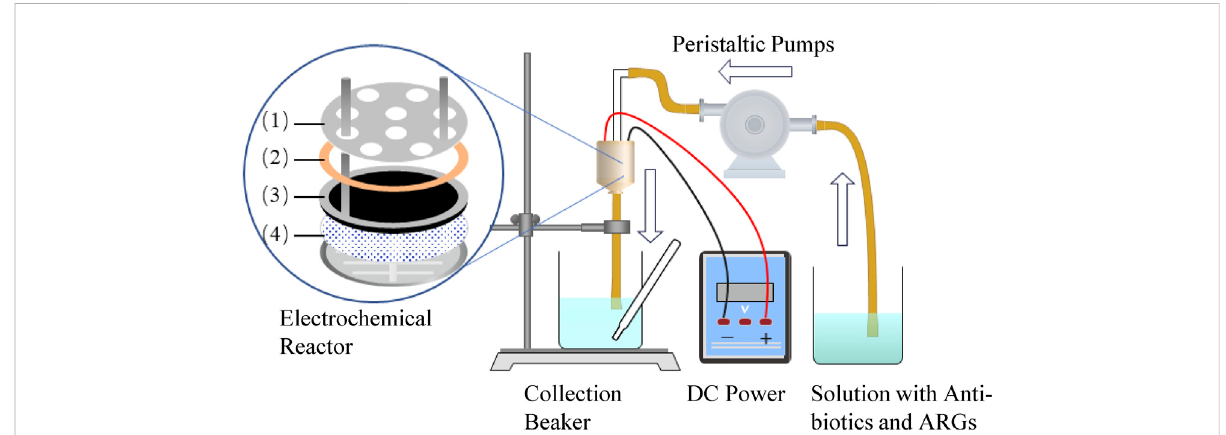
FIGURE 1 Schematic of the experimental setup. The electrochemical membrane reactor was designed with a polycarbonate fi lter casing, which included (1) a perforated titanium cathode, (2) an insulated silicone electrode spacer and seal (0.8 mm), (3) a titanium anode ring pressed onto a CNT anode, and (4) a CNTM/CNTM-COOH anode reactor supported by a PTFE